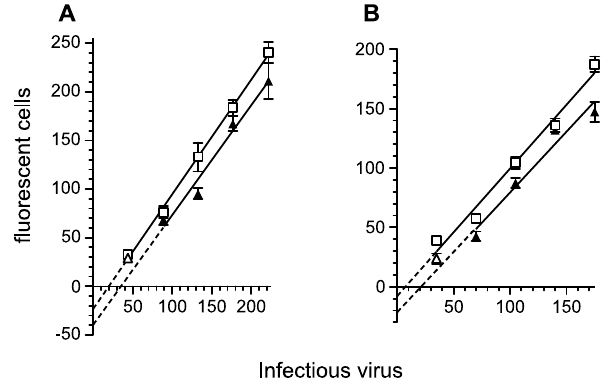
Figure 6. Neutralization of HIV-1 89.6 by sera from macaques immunized with HIV-1 SF162 immunogens. Low doses of the relatively neutralization resistant, subtype B HIV-1 89.6 isolate were incubated at 37 u C for four hours with a 1 in 20 dilution of either a control serum (open squares) or serum from a macaque (solid triangles) immunized with HIV-1 SF162 recombinant immunogens. (Open triangles represent data sets close to background levels which have been excluded from the analysis of regression lines). The mixture was then added to GHOST cells and allowed to absorb for 24 hours. The cells were washed and cultured for a further 24 hours. Results are plotted with regression lines; parameters are given as means with standard errors A . Controls: m=1.179 6 0.063 fluorescent cells/infectious dose of virus; ; c= 2 23.33 6 9.142 fluorescent cells; 95% confidence interval for x-intercept=3.816 to 32.93 infectious virus doses; immunized macaque from group 2.1: m=1.129 6 0.112 fluorescent cells/infectious dose of virus; c= 2 39.76 6 18.21 fluorescent cells; 95% confidence interval for x- intercept=0.7662 to 58.31 infectious virus doses:. The difference between the x-intercepts=15.6 infectious virus doses. The difference between the gradients was not statistically significant (p=0.6896) so that the data were pooled and a common gradient calculated: 1.16188. The intercepts on the vertical axis are significantly different (p=0.001359). B . Controls: m=1.075 6 0.053 fluorescent cells/infectious dose of virus; ; c= 2 7.975 6 6.153 fluorescent cells; 95% confidence interval for x-intercept= 2 5.086 to 17.81 infectious virus doses; immunized macaque from group 5.1: m=1.025 6 0.083 fluorescent cells/infectious dose of virus; c= 2 23.13 6 10.64 fluorescent cells; 95% confidence interval for x-intercept=0.3555 to 38.59 infectious virus doses:. The difference between the x-intercepts=15.1 infectious virus doses. The difference between the gradients was not statistically significant: p=0.6064 so that the data were pooled and a common gradient calculated: 1.05833. The intercepts on the vertical axis are significantly different (p ,